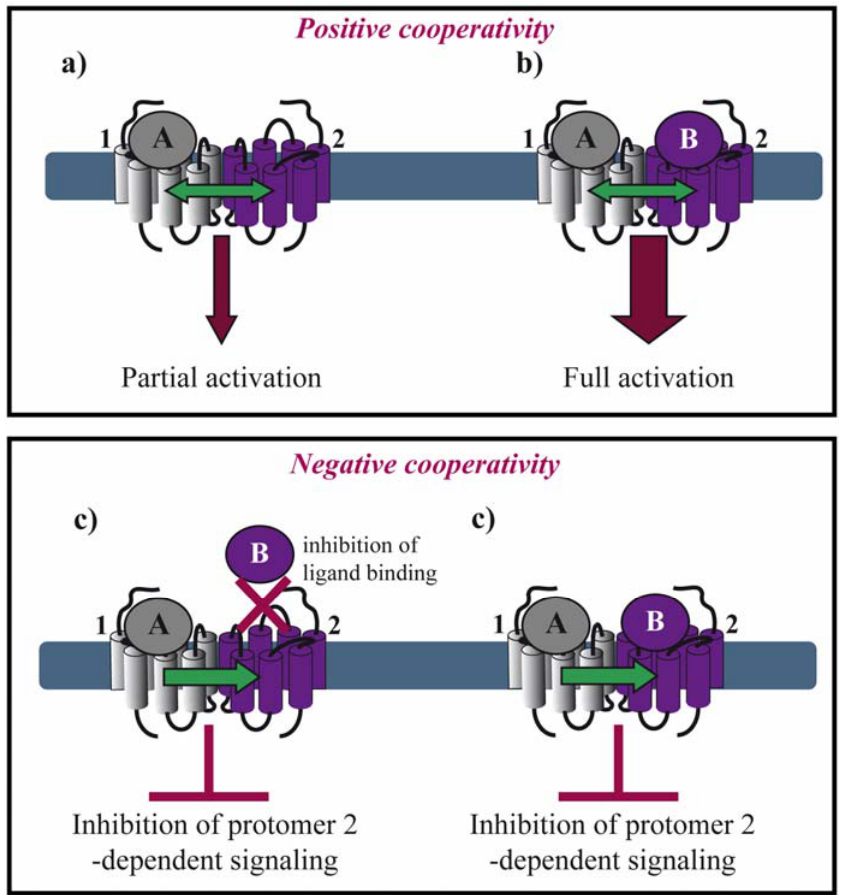
Figure 2. Asymmetry in ligand binding within a GPCR dimer. Positive cooperativity: (a) One agonist (A) binding to a dimer results in GPCR partial activation; but (b) two agonists (A, B) are required for full activation. Ligand B can be identical to agonist A or a different agonist or an antagonist, which can enhance GPCR activation. Negative cooperativity; (c) Agonist A binding to protomer 1 inhibits the binding of ligand B to protomer 2, therefore suppressing protomer 2-dependent signaling; or (d) agonist A binding to protomer 1 inhibits ligand B-induced protomer 2